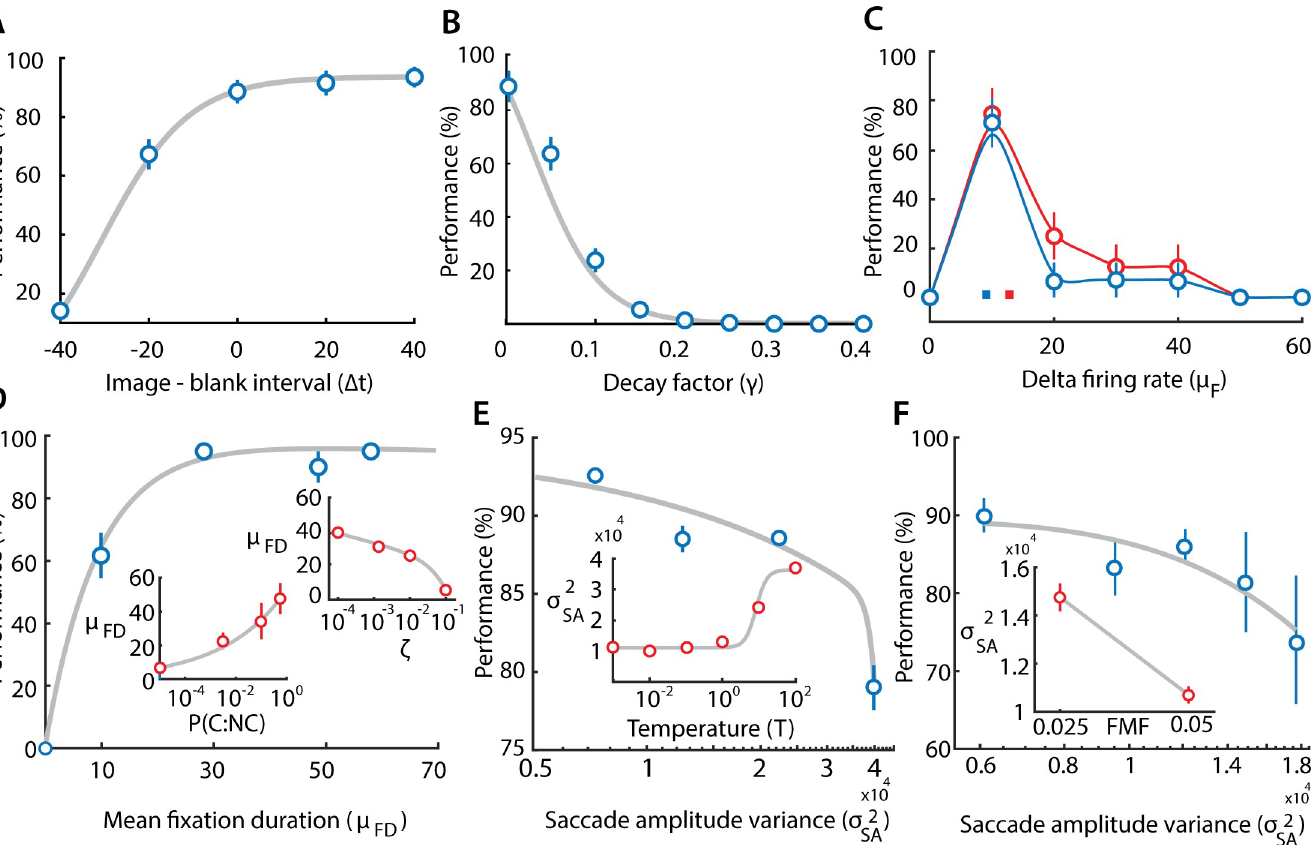
Fig 5. Effect of model parameters on change detection success. A. Change in model performance (success rates, % correct) with varying the relative interval of the images and blanks, measured in units of time bins ( Δ t = 25 ms/time bin; Table 1), while keeping the total image+blank interval constant (at 50 time bins). Positive values on the x-axis denote larger image intervals, as compared to blanks, and vice versa, for negative values. Blue points: Data; gray curve: sigmoid fit. B. Same as in panel (A), but with varying the maximum decay factor ( γ ; Eq 2). Curves: Sigmoid fits. C. Same as in panel (A) but with varying the firing rate prior ( μ f ) for image pairs with the lowest (blue; bottom 33 rd percentile) and highest (red; top 33 rd percentile) magnitudes of firing rate changes. Curves: Smoothing spline fits. Colored squares: μ f corresponding to the center of area of the two curves . D. Same as in panel (A), but with varying the mean fixation duration ( μ FD ; measured in time bins, Δ t = 25 ms/ time bin). (Inset; lower) Variation of μ FD with prior ratio of change to no change (P(C:NC)). (Inset; upper) Same as lower inset but with varying threshold decay rate z (Table 1). E. Same as in panel (A), but with varying saccade amplitude variance ( σ 2 SA ). (Inset) Variation of σ 2 SA with the softmax function temperature parameter (T) (see text for details). F. Same as in panel (A), but with varying saccade amplitude variance ( σ 2 SA ). (Inset) Variation of σ 2 SA with the foveal magnification factor (FMF). Other conventions in B-F are the same as in panel A. Error bars (all panels):